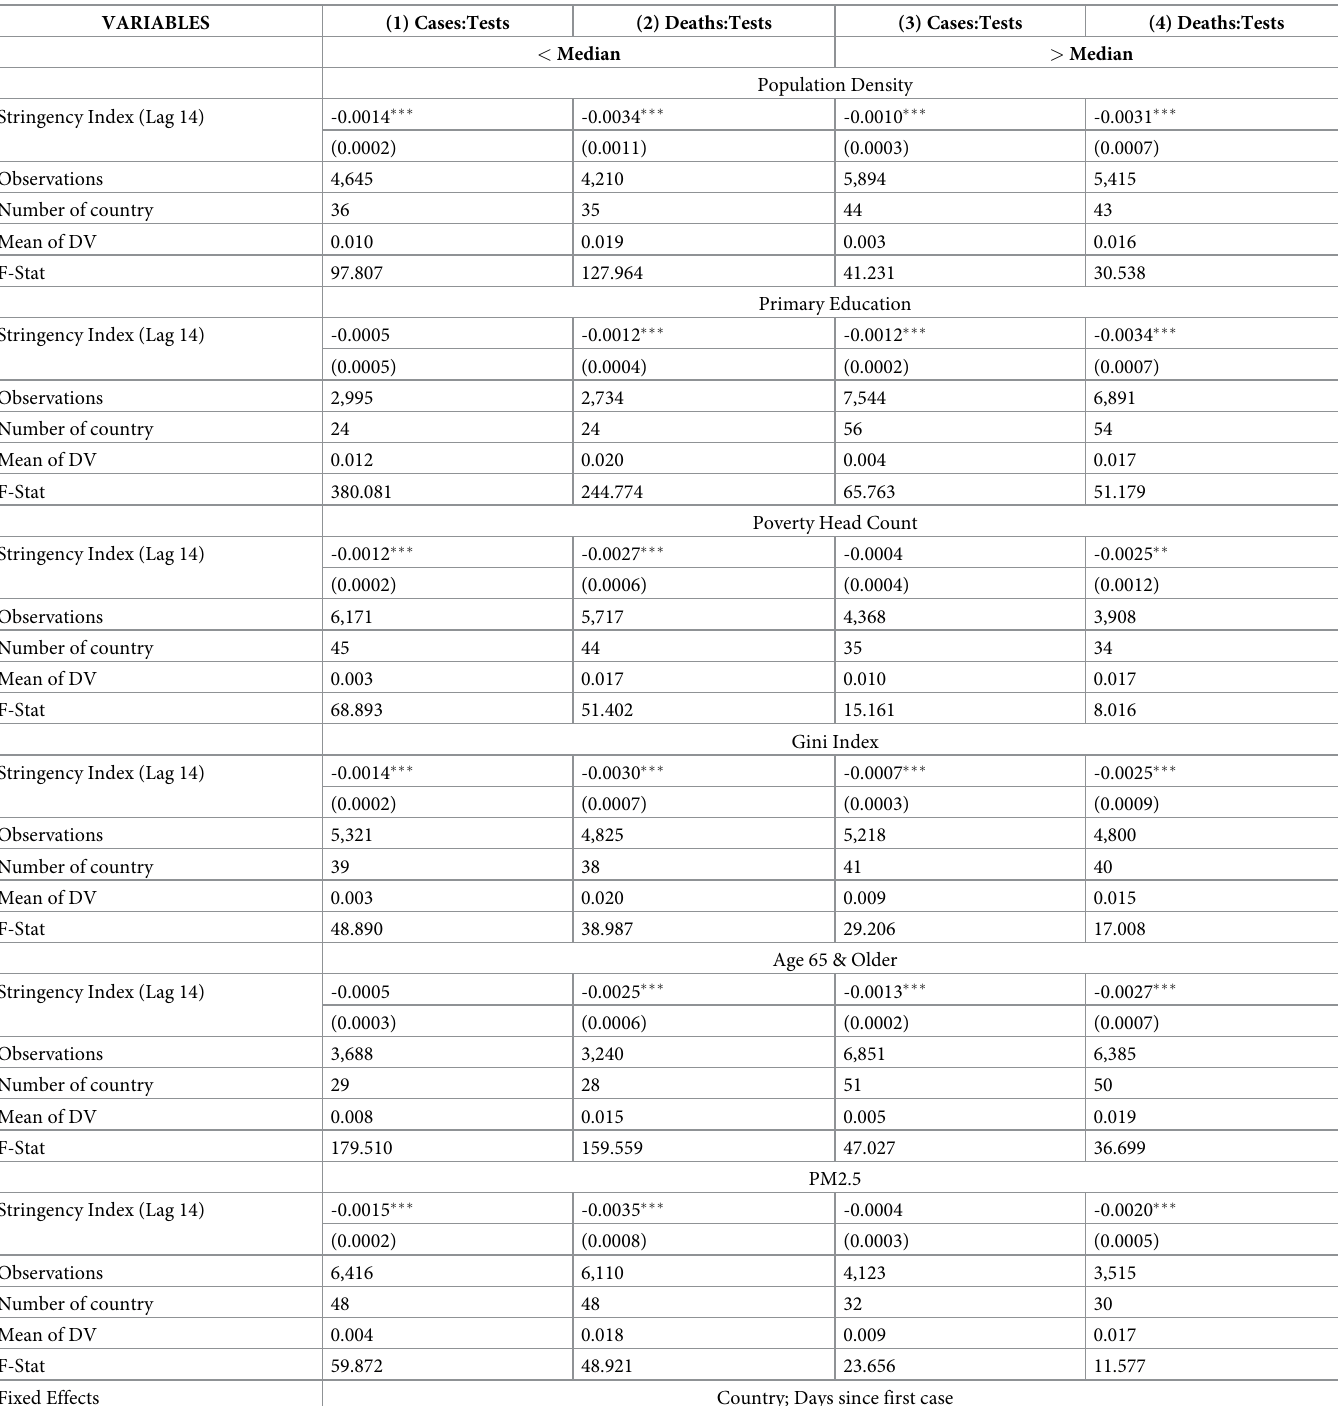
Table 6. Heterogenous impact of stricter restrictions on growth rates